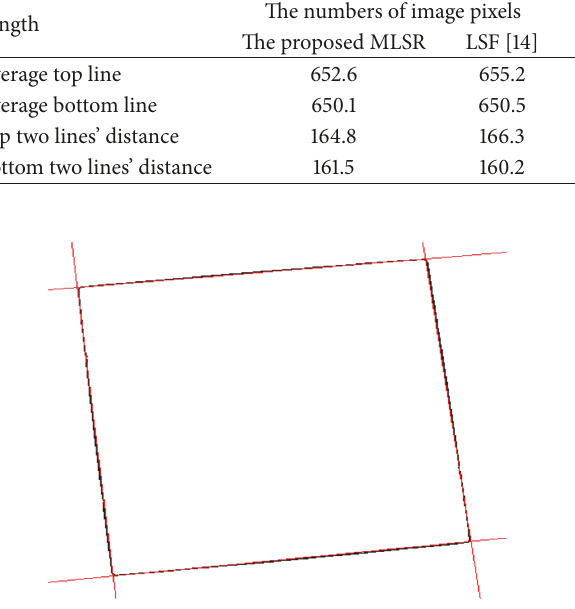
Figure 9: Edge estimation result under red background.